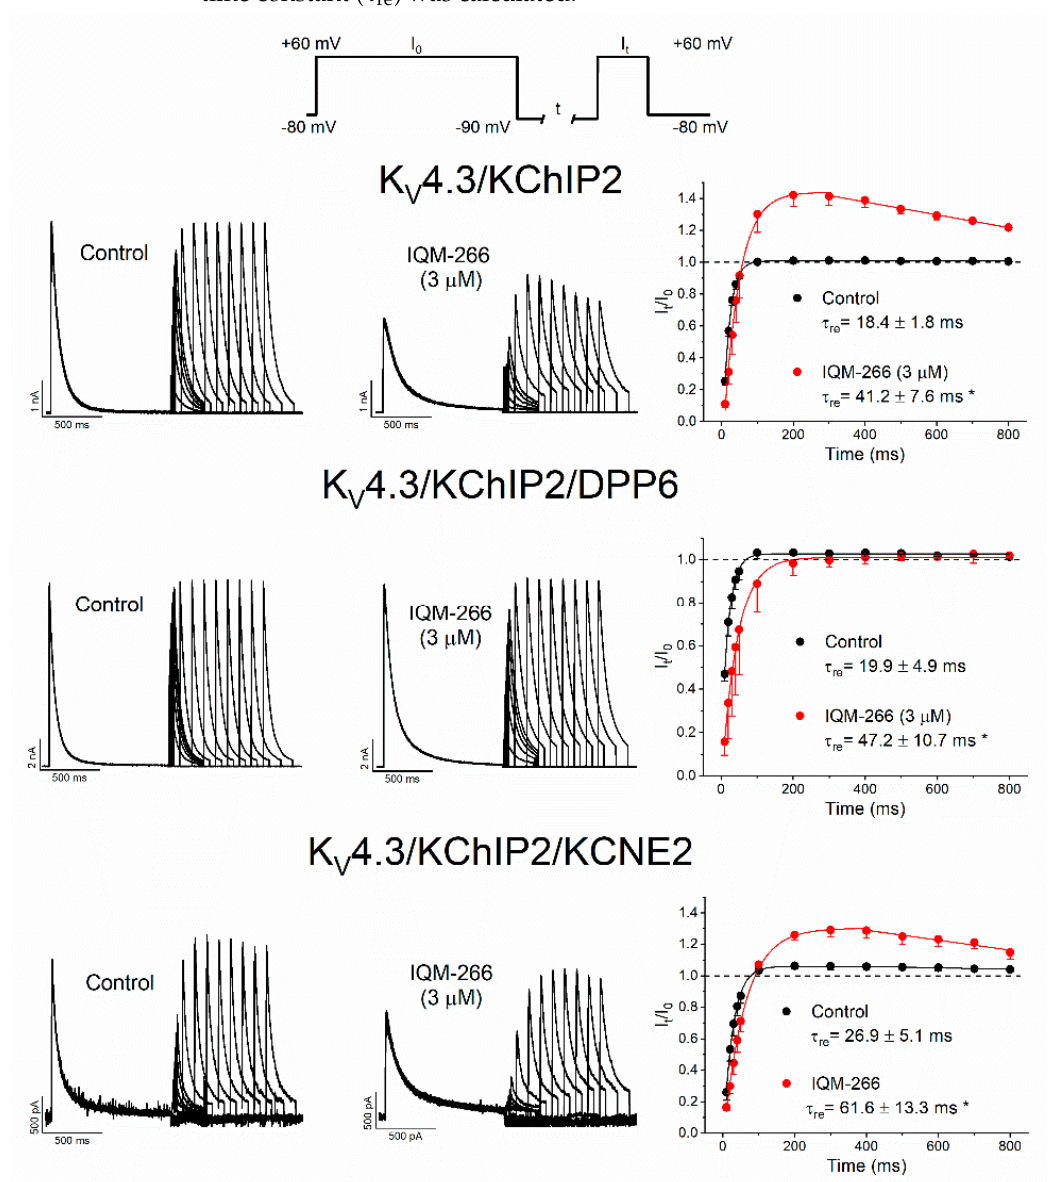
Figure 6. Effects of IQM-266 on the recovery kinetics from inactivation of K V 4.3/KChIP2, K V 4.3/KChIP2/DPP6 and K V 4.3/KChIP2/KCNE2 channels. Left panel shows original records obtained after applying the pulse protocol shown in the upper panel of the figure. Right panels show the data obtained after plotting the I t /I 0 vs. the interpulse period separating both the conditioning and the test pulse. Each point represents the mean ± S.E.M. of n = 5 cells (from n = 5 transfections) for K V 4.3/KChIP2, n = 6 cells (from n = 5 transfections) for K V 4.3/KChIP2/DPP6 channels and of n = 6 cells (from n = 5 transfections) for K V 4.3/KChIP2/KCNE2 channels. *: p < 0.05.